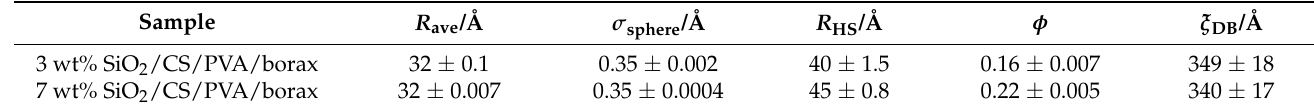
Table 1. The result of the fitting